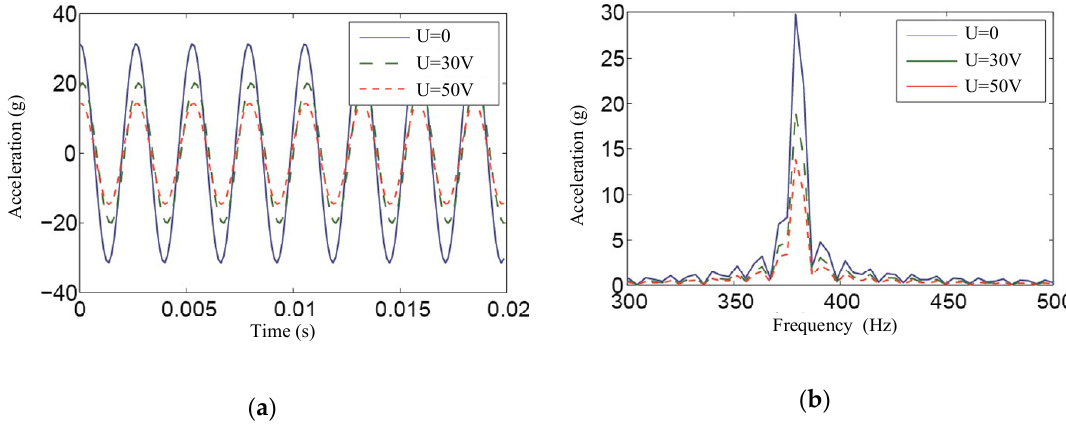
Figure 16. Vibration response in the ( a ) time domain and ( b ) frequency domain under different control voltages.